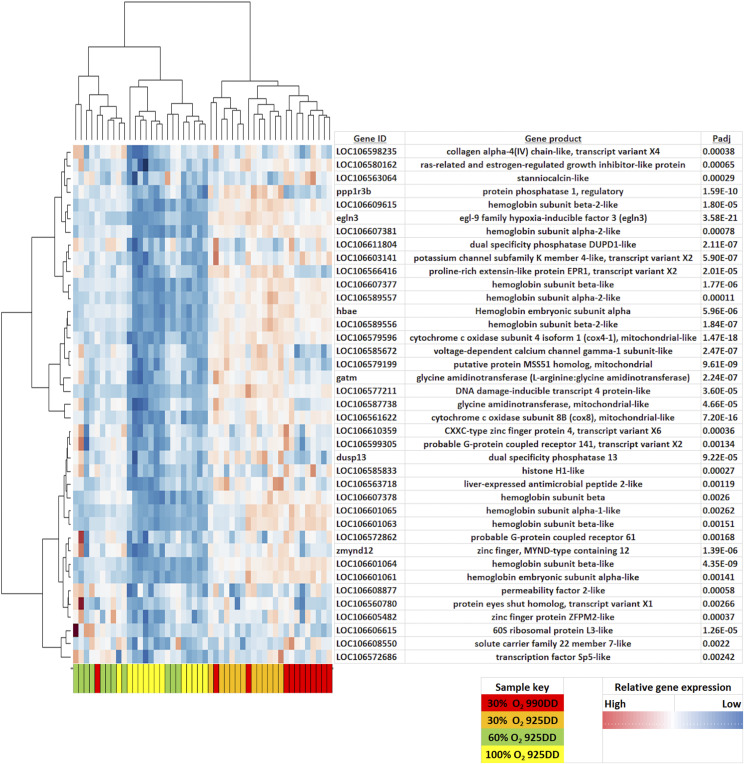
Heat map of differentially expressed genes (Padj <0.05, fold-change >1.75) across salmon raised in 30% O2, 60% O2 or 100% O2 treatments.